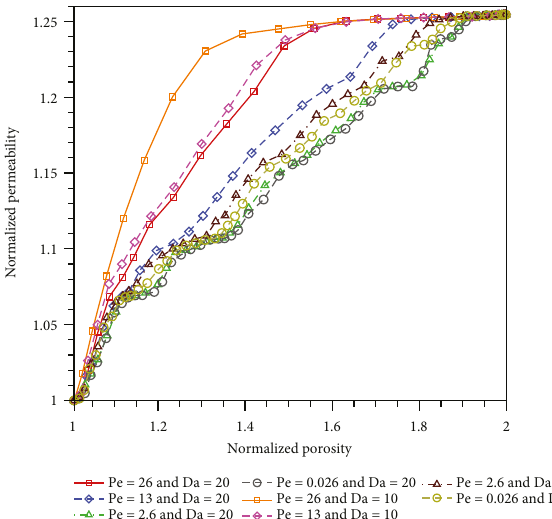
Figure 4: Normalized permeability versus normalized porosity at di ff erent Pe and Da numbers for initially mixed mineral